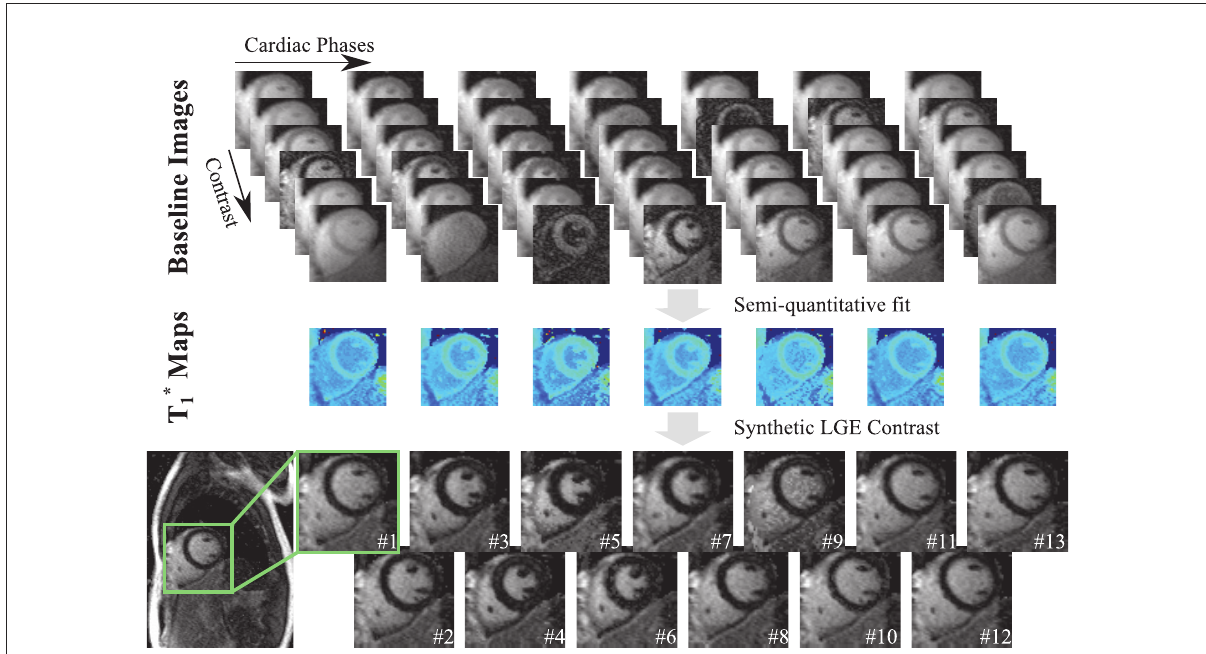
FIGURE3 The post-processing pipeline for generating the proposed functional LGE images from the acquired T 1 -weighted data. For each cardiac phase, the proposed sequence acquires multiple images with different T 1 weighting, denoted as Baseline Images. A two-parameter fit is performed on these images to obtain semi-quantitative T ∗ 1 maps for each cardiac phase. Finally, a virtual inversion time is retrospectively chosen to synthesize functional LGE images for all cardiac